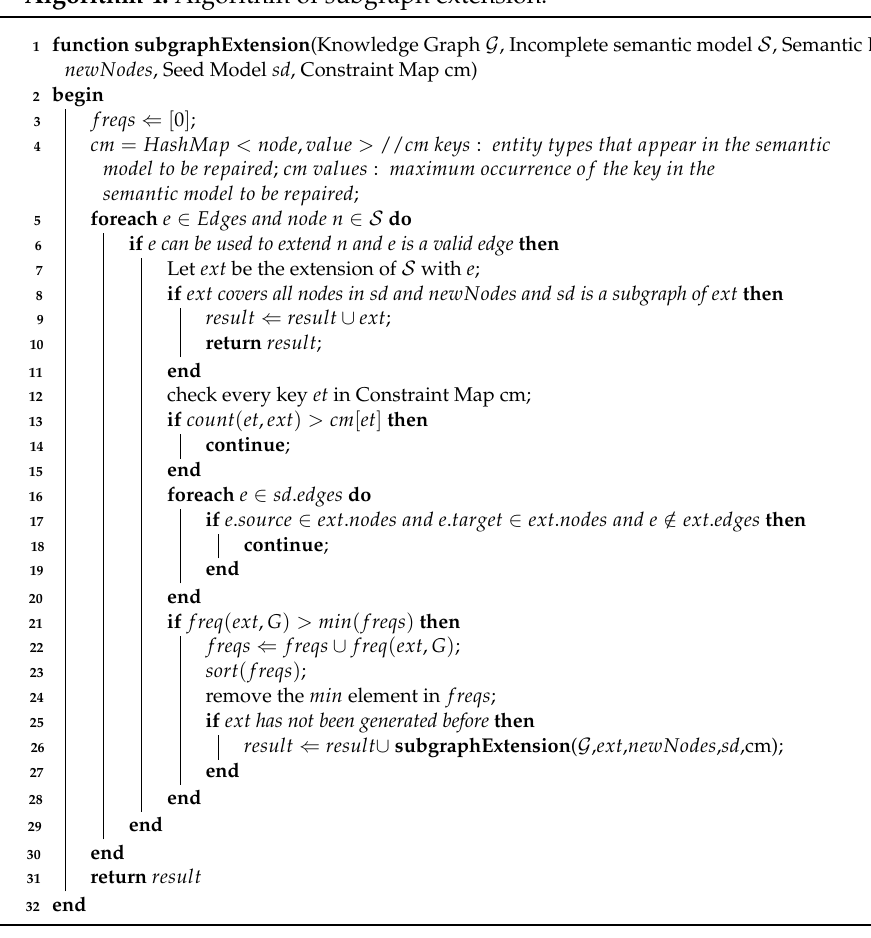
Algorithm 4: Algorithm of subgraph